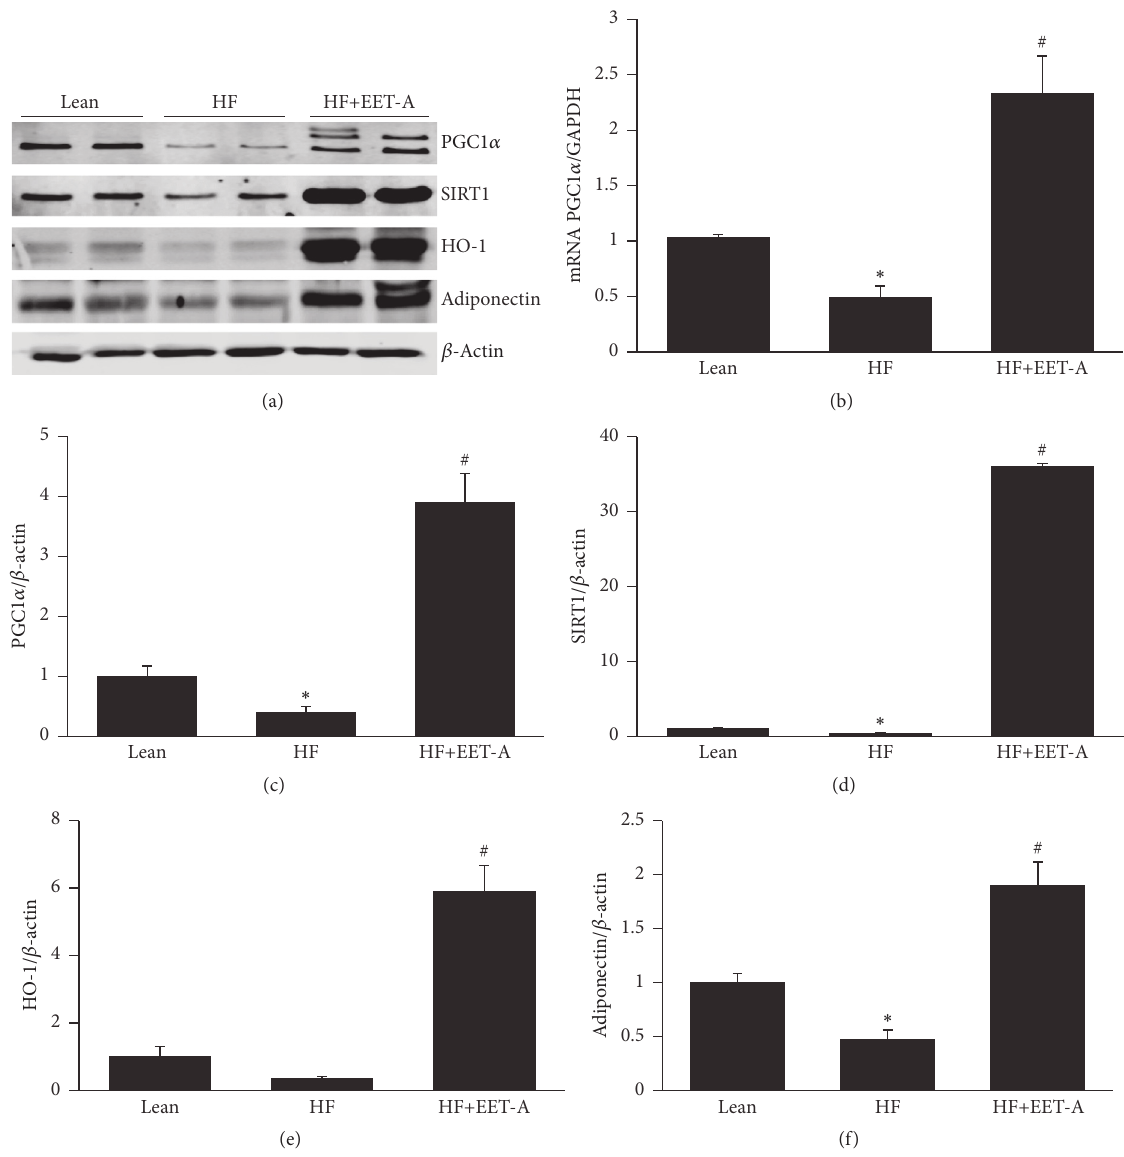
Figure 5: Effect of long-term EET-A treatment on the expression of PGC-1 𝛼 , SIRT1, HO-1, and adiponectin in adipose tissue of mice fed HF diet. (a) Representative Western blots, (b) protein, and (c) mRNA levels of PGC-1 𝛼 . Protein levels of (d) SIRT1, (e) HO-1, and (f) adiponectin. Data are normalized to 𝛽 -actin for protein or GAPDH for mRNA. Results are mean ± SE, 𝑛 = 4 , ∗ 𝑝 < 0.05 versus lean, and # 𝑝 < 0.05 versus